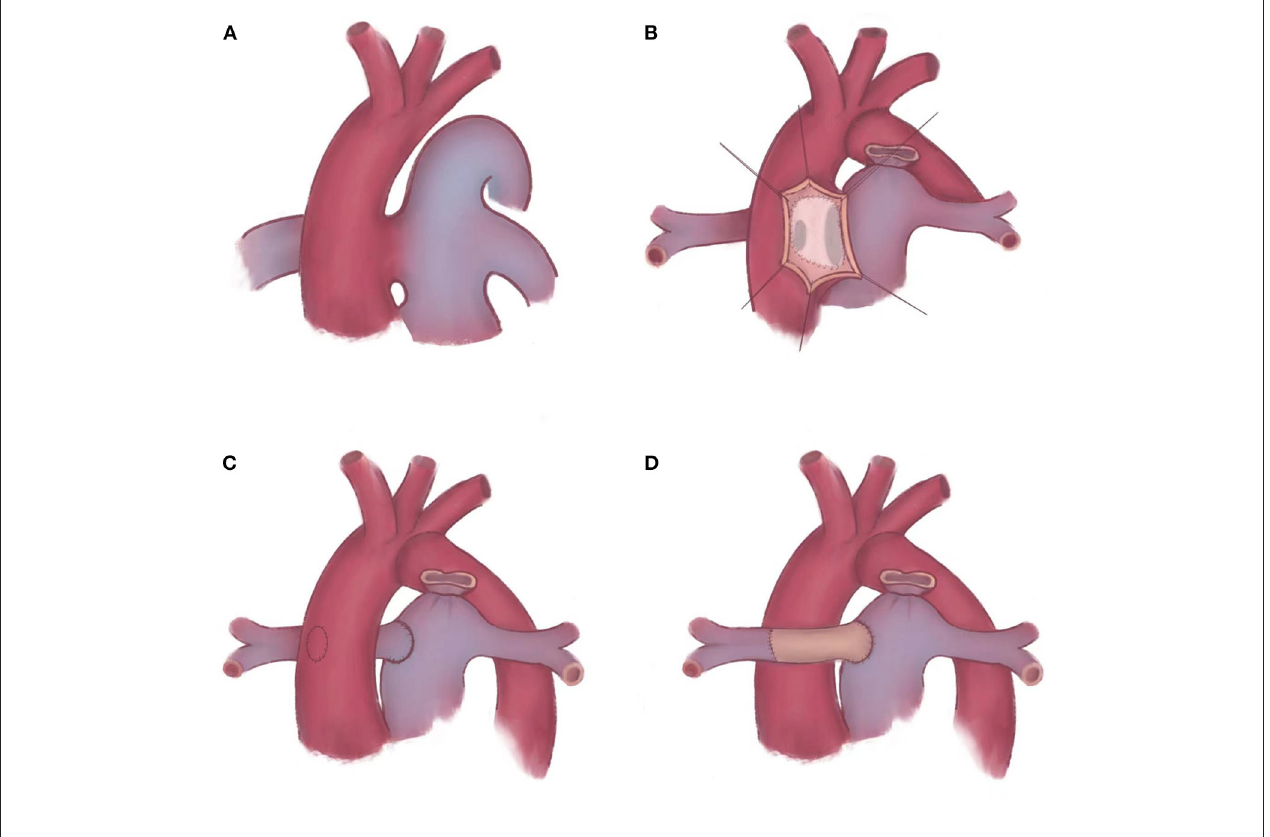
FIGURE 2 | Schematic diagram of repairing APW and AORPA. (A) Berry syndrome is a complex deformity, such as APW, AORPA, and IAA. (B) An trimmed intra-aortic baffle patch is placed to reconstruct the continuity of RPA. (C,D) AORPA is cut-off directly and reconstructed to the right lateral side of MPA. (C) RPA is anastomosed to the MPA in situ . (D) RPA is anastomosed to the MPA at the anterior of the aorta with patch augmentation in a similar fashion to the LeCompte maneuver. APW, aortopulmonary window; AORPA, the aortic origin of the right pulmonary artery; IAA, interrupted aortic arch; RPA, right pulmonary artery; MPA, main pulmonary artery. re-operated at the 22nd month after the primary